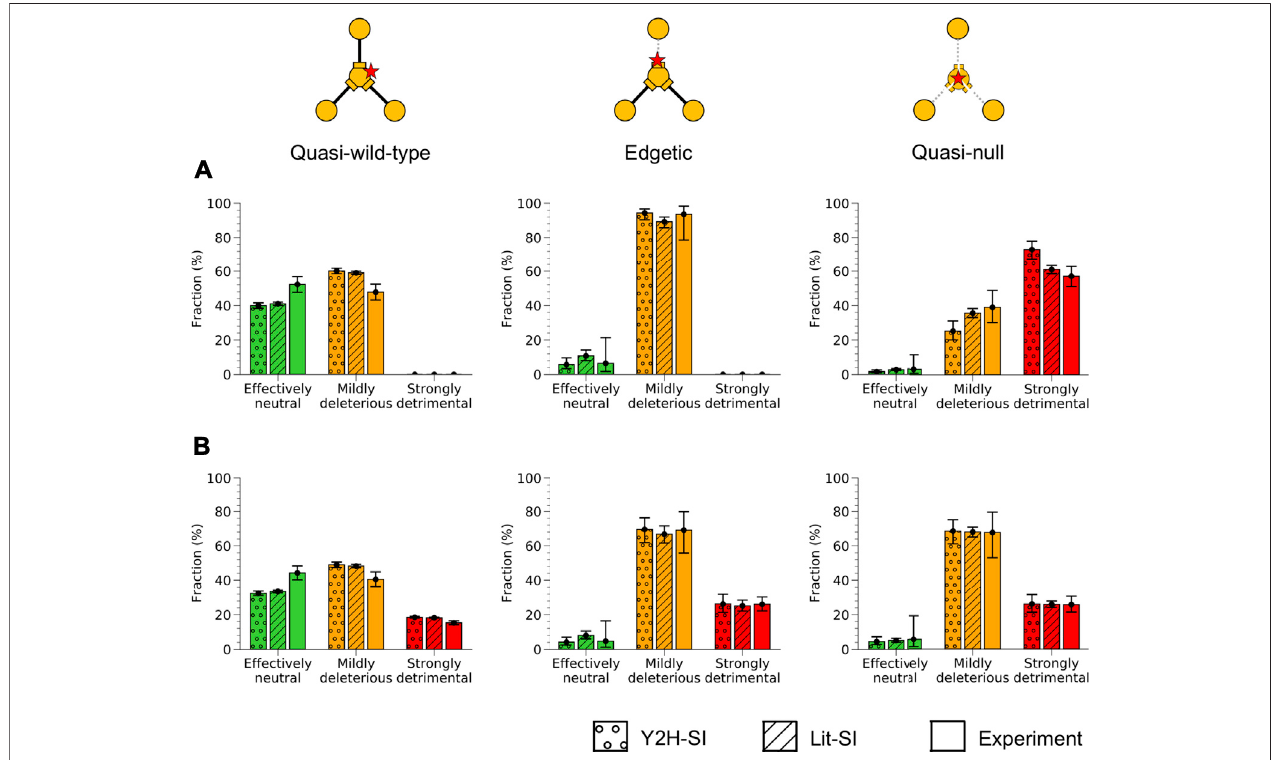
FIGURE 6 | Fitness effect for different mutation edgotypes in human. Probabilities for quasi-wild-type mutations (left) , edgetic mutations (middle) , and quasi-null mutations (right) to be effectively neutral, mildly deleterious, or strongly detrimental in human. Probabilities were estimated from mutation edgotypes obtained by structure-based predictions in the two human structural interactomes, Y2H-SI and Lit-SI, and from mutation edgotypes obtained by experiments. (A) Fitness effect calculatedassuming thatstrongly detrimentalmutationsareallquasi-null(Assumption I). (B) Fitnesseffectcalculatedassuming thatstrongly detrimentalmutations are as likely as mildly deleterious mutations to be quasi-wild-type, edgetic or quasi-null (Assumption II). Error bars represent 95% con fi dence